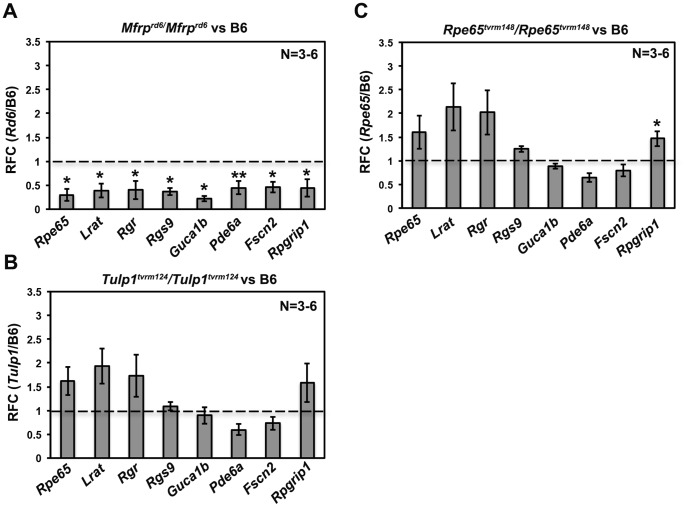
qRT-PCR analysis of RPE and retinal- specific genes in homozygous Mfrprd6, Tulp1tvrm124 and Rpe65tvrm148 mutants.(A) In homozygous Mfrprd6 mutant mice, the transcripts in the visual cycle (Rpe65, Lrat and Rgr), phototransduction pathway (Rgs9, GuCa1b, Pde6a) and structural components of rods and cones (Fscn2 and RpGrip1) were significantly decreased relative to the wild-type control (B6/J), validating the microarray results. (B) qRT-PCR analysis in Tulp1tvrm124/Tulp1tvrm124 mutants at P14 revealed no significant change in any of the transcripts tested. (C) In Rpe65tvrm148/Rpe65tvrm148 mutants, there was only a significant increase in RpGrip1 from transcripts tested, relative to wild-type (B6/J) controls. The data are expressed as relative fold change (RFC) after normalizing to the wild-type control. RFC was calculated using ΔΔCT method after internal calibration to β-Actin control. Each value represents RFC ± S.E.M. * P<0.05 and ** P<0.001 relative to controls. N = 3–6 per group.